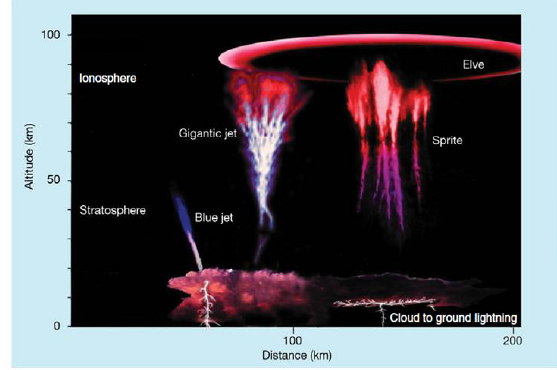
Fig. 6. Depiction of low altitude lightning and TLEs